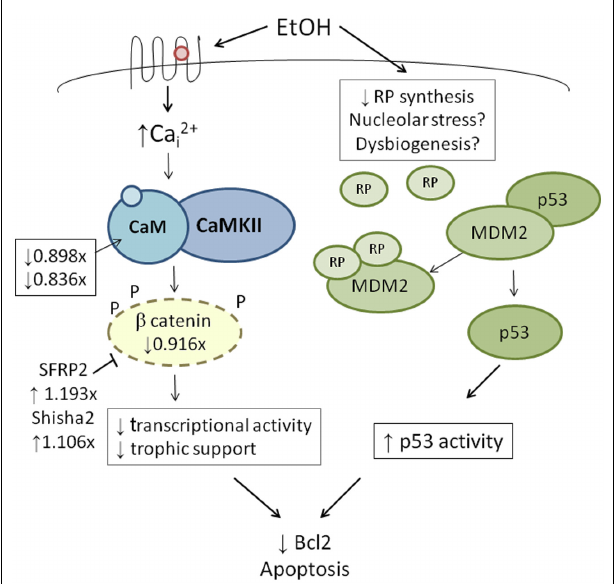
FIGURE 4 | Integration of genetic findings with known ethanol-induced signals in neural crest. The left panel shows how the expressions of genes that participate in ethanol’s apoptosis are altered in within ethanol-sensitiveW98S as compared against ethanol-resistant W98D. Fold-changes in expression are presented.The right panel proposes a mechanism by which ribosome dysgenesis could interact with MDM2 to stimulate p53-mediated apoptosis. In response to cellular stress such as ethanol, a decrease in ribosome synthesis leads to ribosome proteins interacting with MDM2. MDM2 no longer silences p53 and permits p53-mediated activities, including apoptosis, to increase within cells.